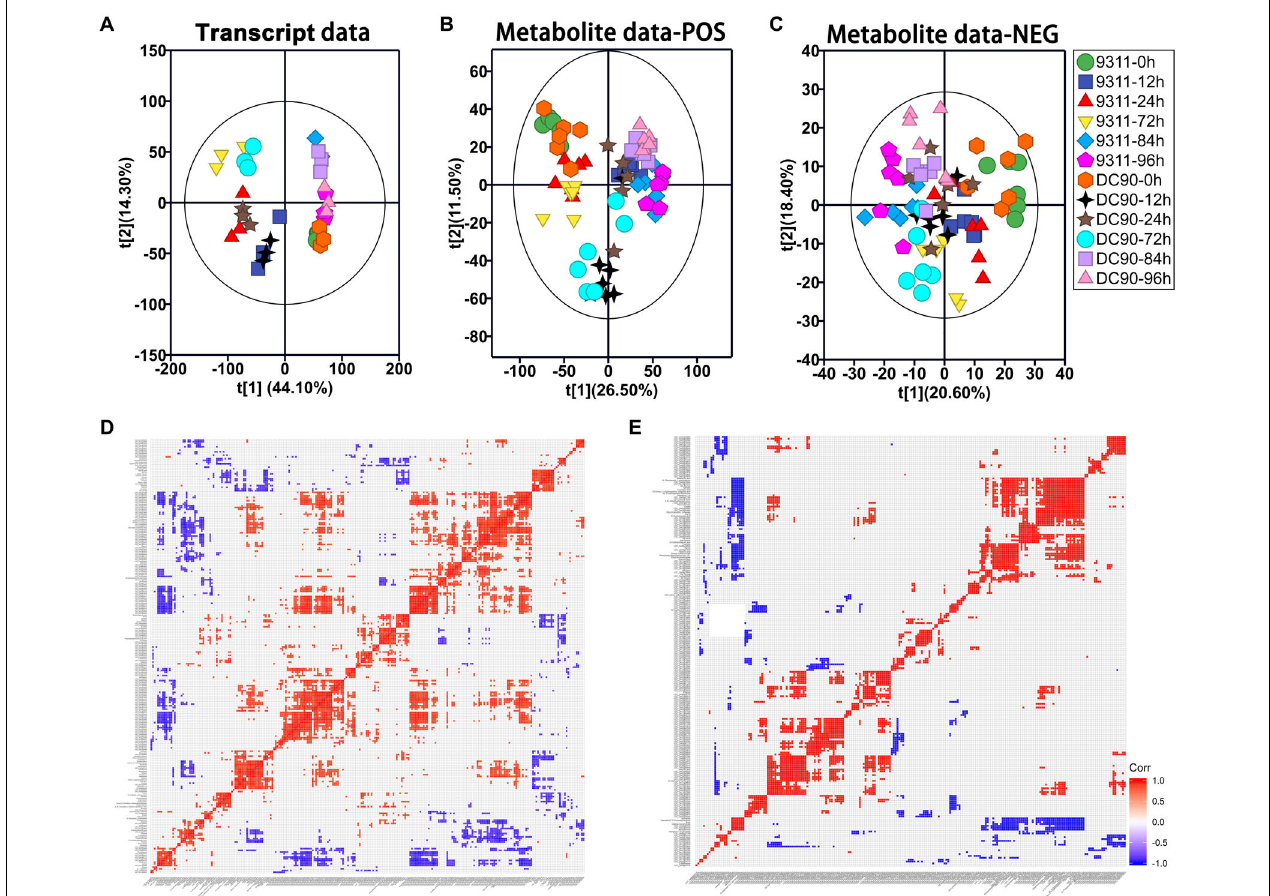
FIGURE 2 | Principal component analysis (PCA) of the transcript and metabolite profiles of 9311 and DC90 samples and correlation analysis of discriminatory DEGs and DAMs, respectively. (A) PCA revealed transcriptomic shifts. (B) PCA revealed metabolomic shifts (POS, positive mode). (C) PCA revealed metabolomic shifts (NEG, negative mode). (D) The significant correlation among chilling-induced DEGs/DAMs. (E) The significant correlation among recovery-induced DEGs/DAMs. The t[1] represents the scoring values of the first principal component, and the t[2] represents the scoring values of the second principal component in (A–C) . Rectangles in (D,E) represent Pearson correlation values of pairs of DEGs or DAMs (see correlation color key). Colored rectangles represent a significant correlation ( P ≤ 0.05).